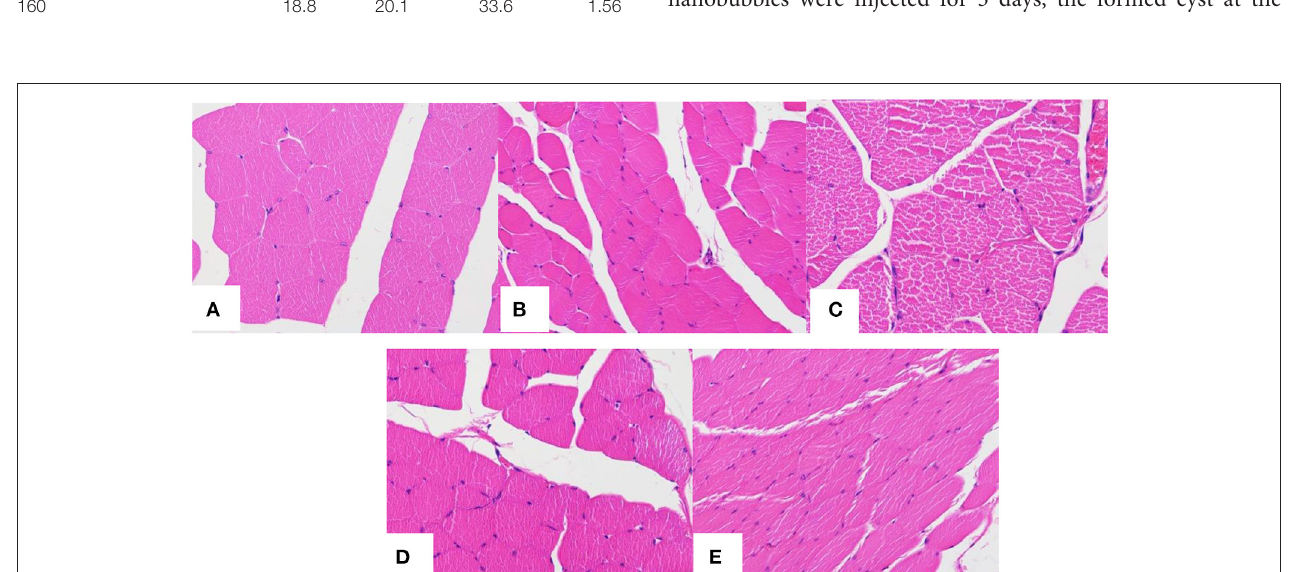
FIGURE 11 | HE staining pictures of mouse muscle after the subcutaneous injection of saline at 1 day (A) and the composite nanobubbles at 1 day (B) , 3 days (C) , 9 days (D) , and 21 days (E) .